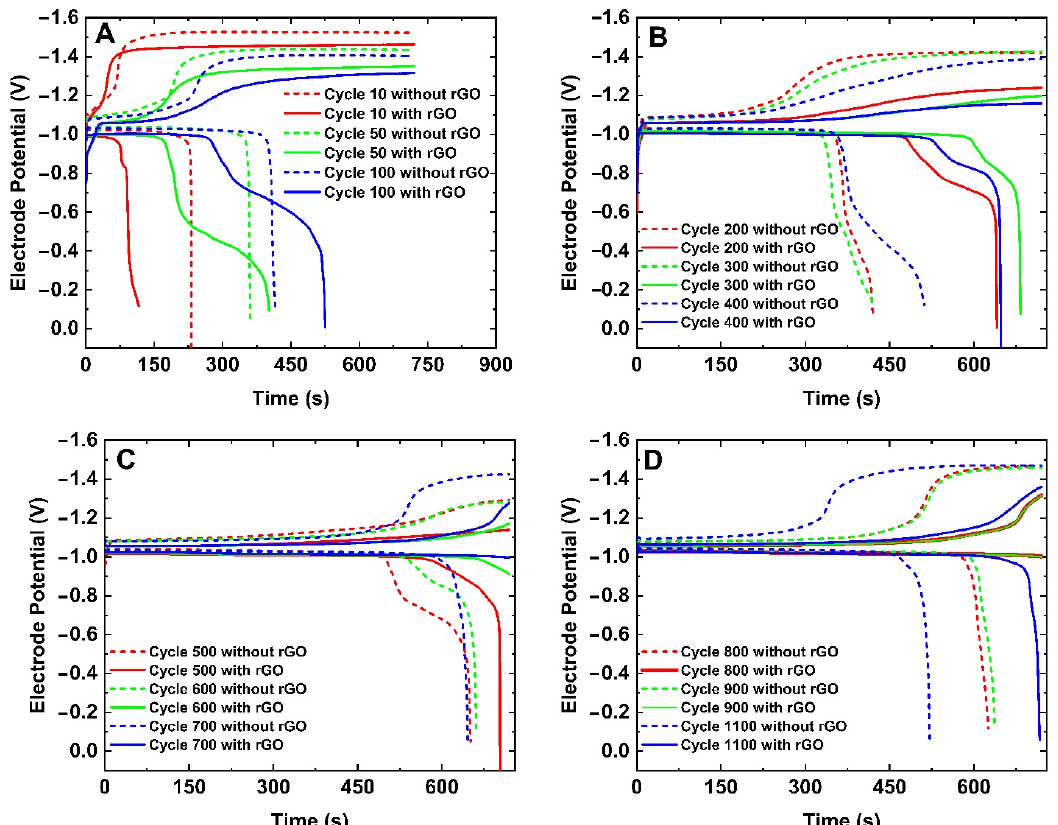
Figure 4. Charge and discharge curve for the nanostructured electrode with rGO and the nanostructured electrode without rGO in 5 M H 2 SO 4 (Potential vs. MSE): ( A ) charge-discharge curves from 10th to 100th cycle; ( B ) charge-discharge curves from 200th to 400th cycle; ( C ) charge-discharge curves from 500th to 700th cycle; ( D ) charge-discharge curves from 800th to 1100th cycle.